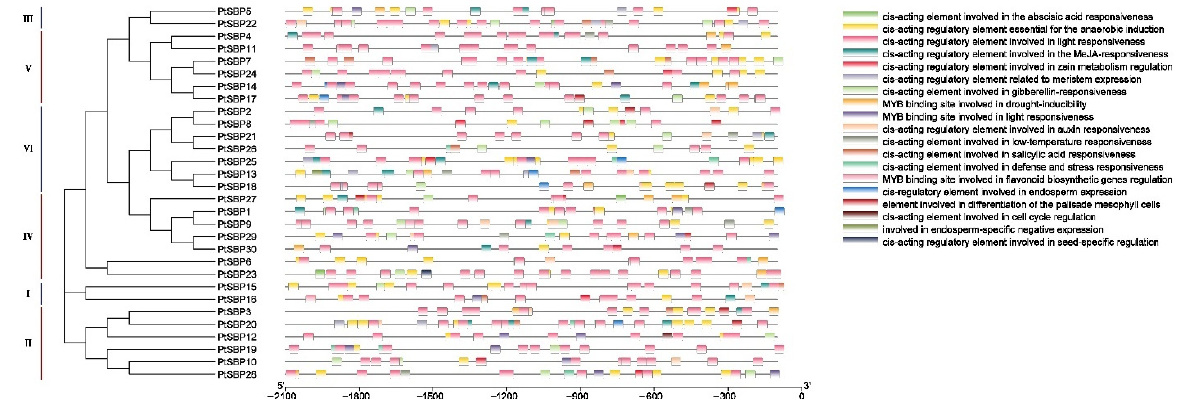
Figure 6. Cis-acting element analysis of the PtSBP promoter. Analysis of cis-acting elements of the poplar SBP gene promoter. The upstream 2000 bp sequences of 30 SBP genes were intercepted for analysis, and the rectangles with different colors represented cis-acting elements with different functions.